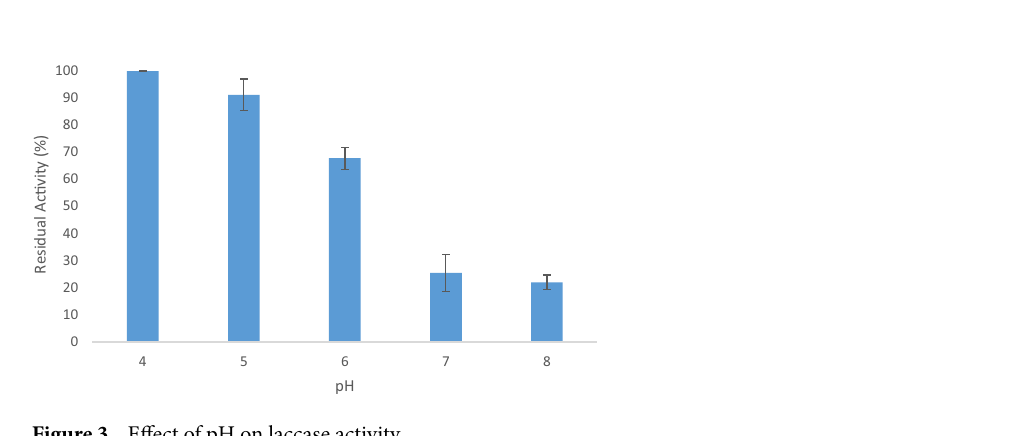
Table1. Optimization study. a All reactions were performed using 2a (0.5 mmol), 3a (1 mmol) at ambient temperature. b Isolated yields. c NR: no reaction.